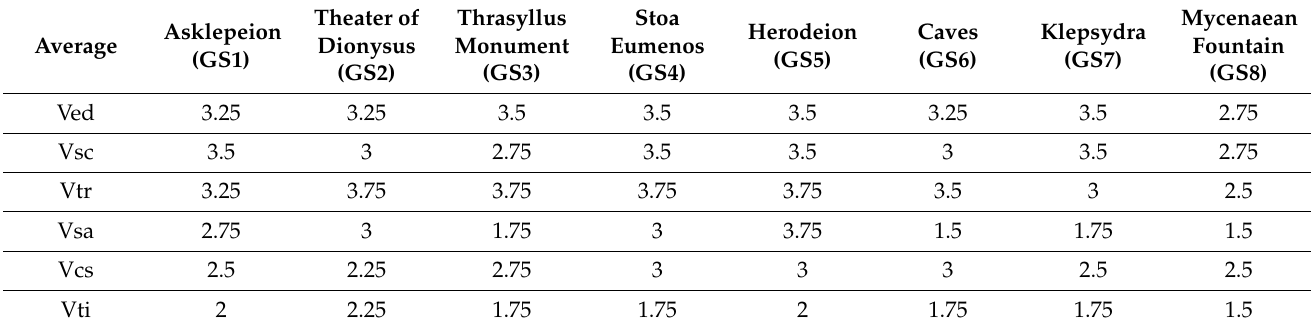
Table 8. Mean value for each axis, for each